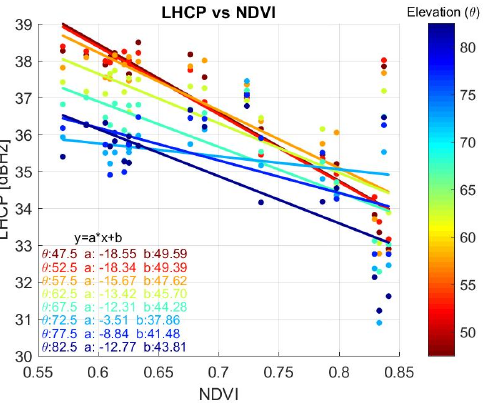
Figure 14. Dependence of the LHCP C/N 0 and the NDVI for different satellite elevation angles, and linear fits.